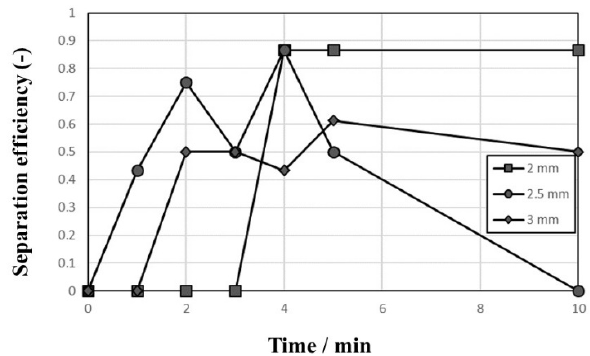
Figure 3. Separation efficiency of Al and STS scraps using 1-mm zirconia ball medium with vibration amplitudes of 2, 2.5, and 3 mm.